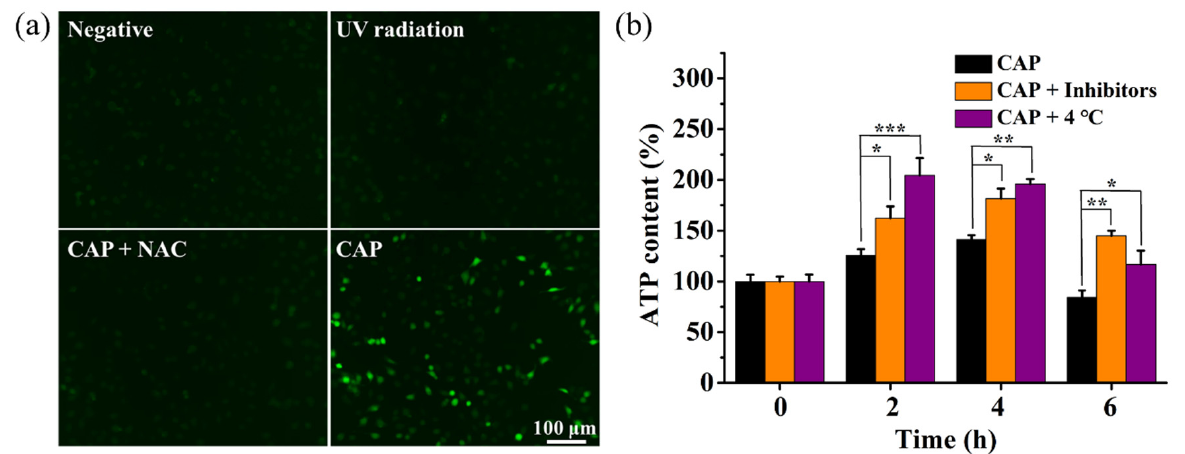
Figure 7. Determination of intracellular Ca 2+ and ATP concentrations after the CAP treatment: ( a ) Fluorescence images of the MCF-7 cells treated with the Fluo 3-AM probe for 2 h under UV radiation and in the presence of RONS scavenger NAC after the CAP treatment for 80 s; ( b ) Time-dependent intracellular ATP content in the presence of endocytosis inhibitors and at low temperature of 4 °C after the CAP treatment for 80 s. The data are shown as mean ± SD ( n = 3). (*) p < 0.05, (**) p < 0.01, and (***) p < 0.001.